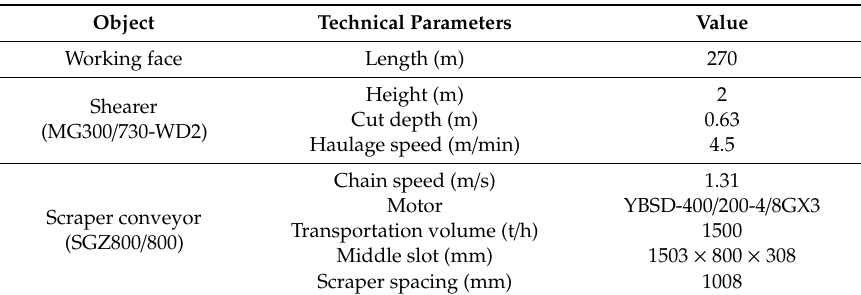
Table 2. Coal mining face and equipment parameters.